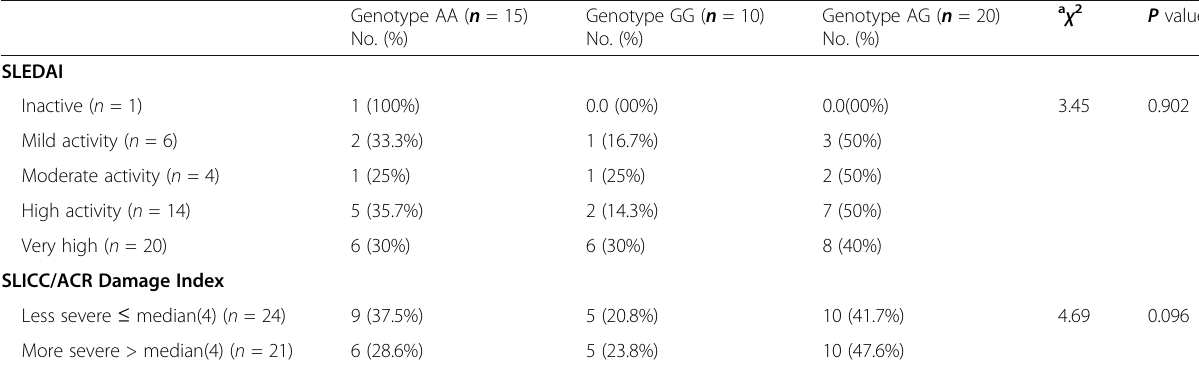
Table 4 XRCC1 Arg 399 Gln polymorphism with SLEDAI and SLICC/ACR Damage Index among SLE patients ( n =